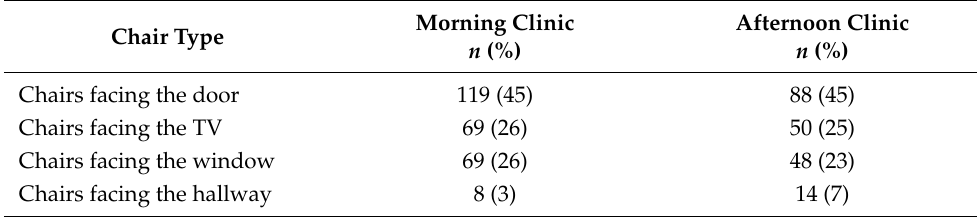
Table 5. Chair occupancy in morning and afternoon